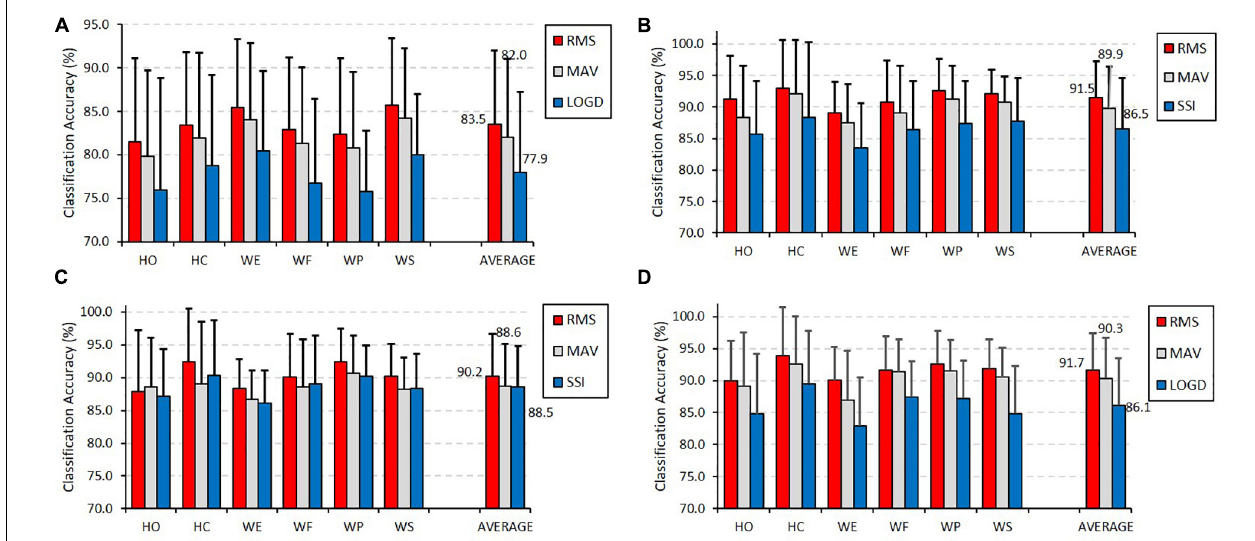
FIGURE 5 | Classification performance of the six motion classes achieved by the top 3 individual optimal TDFs for classifiers of (A) LDA, (B) KNN, (C) ANN, and (D) SVM.